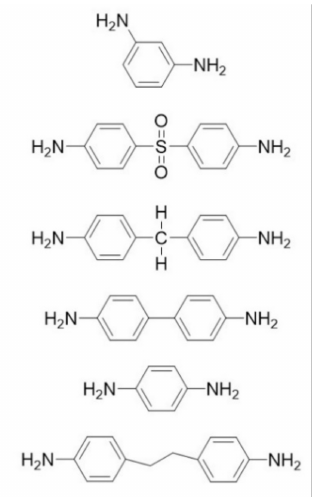
Figure 4. Typical molecular structure of amine-based curing agents.